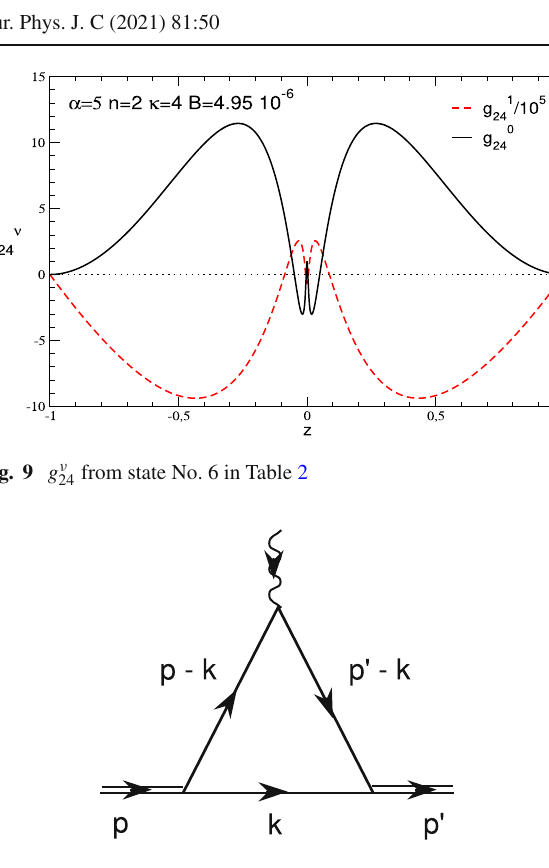
consider inelastic transitions from an initial | i (cid:4) to a final | f (cid:4) state. The elastic form factors are obtained from them as a particular case, with f = i